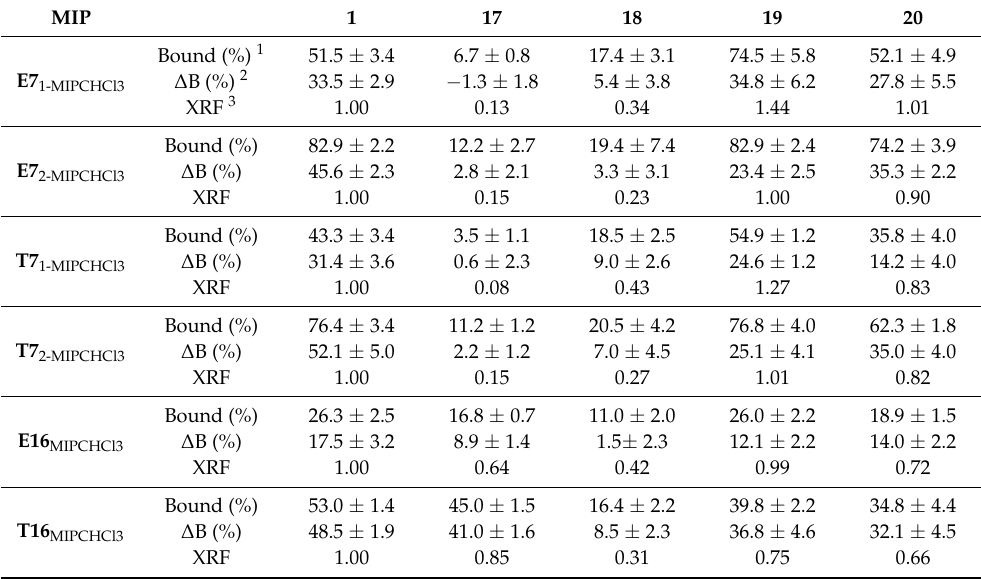
Table 2. Non-competitive cross-reactivity results for 1 -MIPs against cocaine ( 17 ), morphine ( 18 ), ephedrine ( 19 ) and phenylpiperazine ( 20